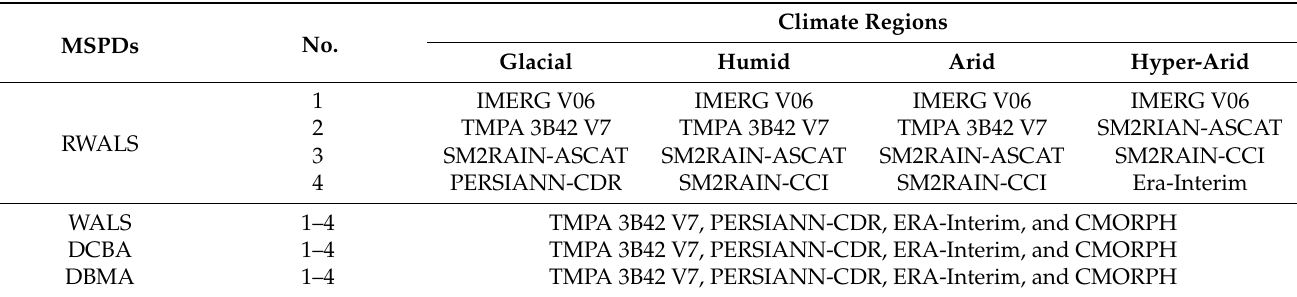
Table 2. Combination of different SPDs used to develop the MPDs over